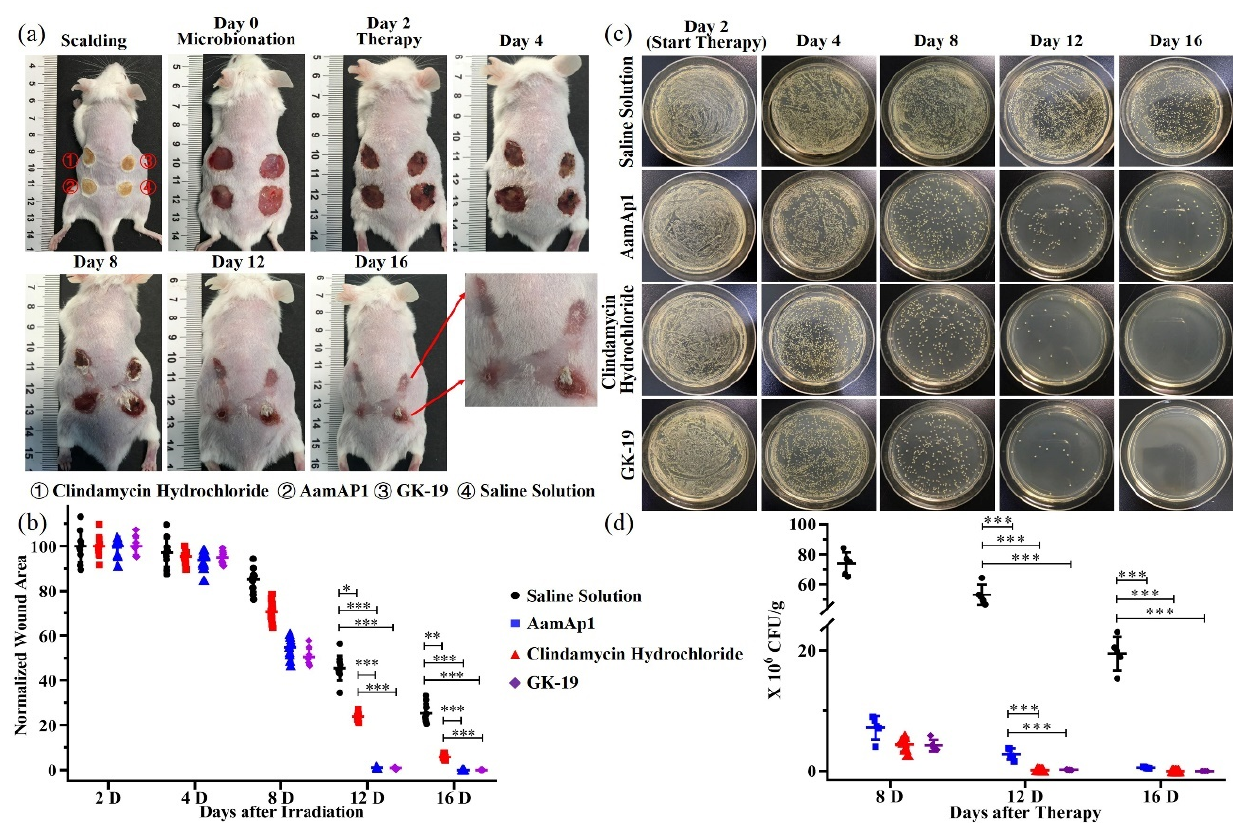
Figure 4. The bactericidal and healing effect of GK-19 on MRSA inoculated onto scalded dorsal skin of mice. ( a ) Time course images of mice infected by MRSA . Infected dorsal skins of the mice were treated with saline solution, AamAp1, clindamycin hydrochloride, or GK-19, respectively, twice every day (n = 10). The concentrations of drugs was 50 μ M. ( b ) Quantitative analyses of wound areas using Image J software. ( c , d ) Time course bacterial count in MRSA infected wounds after treatment with different antimicrobial peptides. Skin tissues of different groups were sampled on days 2, 4, 8, 12 and 16. Tissue suspensions were diluted with sterile saline solution and 50 µ L of tissue suspensions was then plated in the MHA culture plates. Images were taken 18–24 h after inoculation. The quantitative analyses of colonies were performed using Image J software or visual observation (n = 5). * p < 0.05, ** p < 0.01, *** p < 0.001.